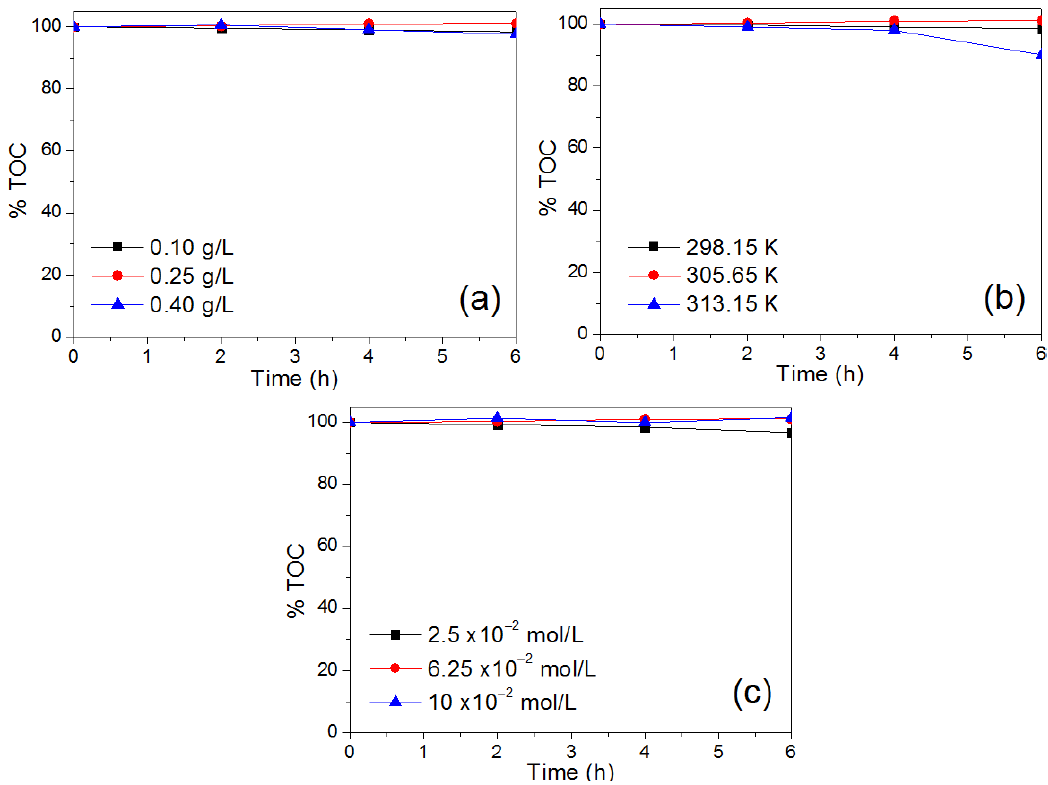
Figure 14. Percentage of total organic carbon during glycerol photo-oxidation with effect on ( a ) amount of catalyst, ( b ) reaction temperature, and ( c ) initial glycerol concentration.